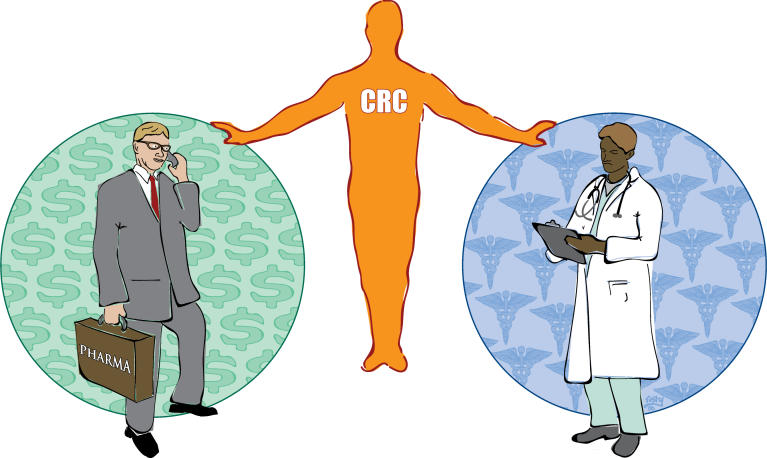
A third party—the CRC—should be placed between drug companies and clinical researchers(Illustration: Rusty Howson, sososo design)